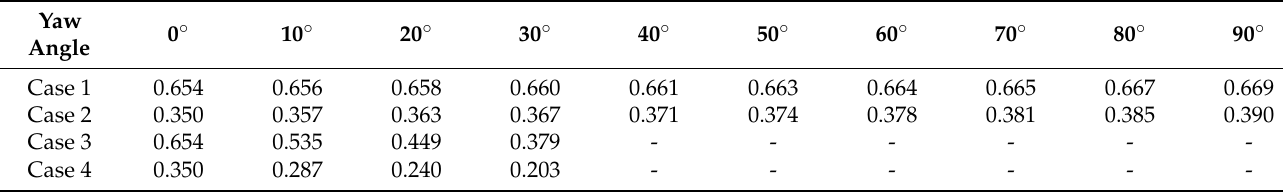
Table 2. Suction coefficients for each case in the experiment.